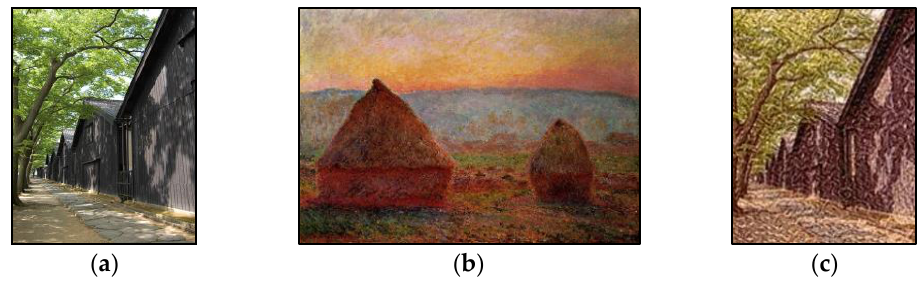
Figure 14. ( a ) Landscape, ( b ) Monet, “Haystacks series”, ( c ) Stylized image.